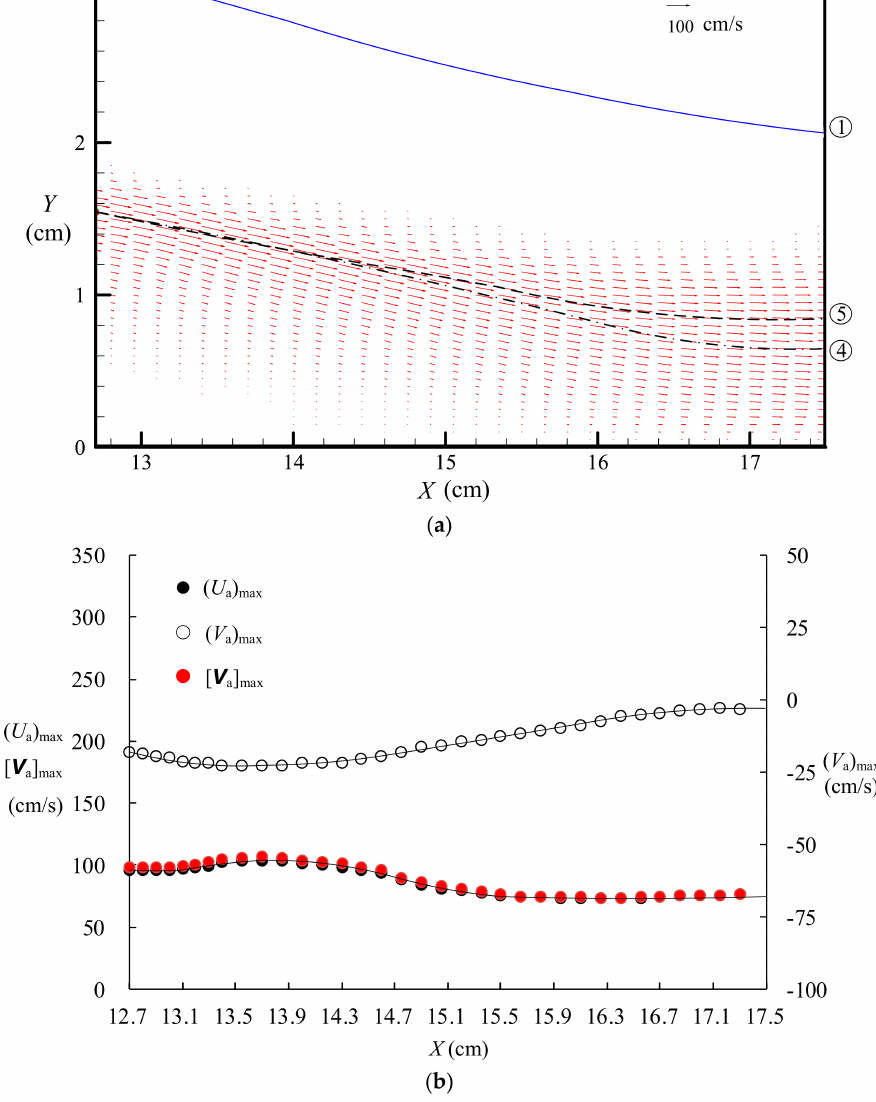
Figure 19. ( a ) Mean velocity field of air bubbles for 12.7 cm ≤ X ≤ 17.5 cm, in which the first water–air interface (marked by 1 (cid:13) ), the virtual boundary ( 4 (cid:13) ), and the dashed curve representing positions for the maximum mean streamwise velocity ( 5 (cid:13) ) are highlighted; ( b ) Variations of the maximum mean streamwise, transverse, and resultant velocities of air bubbles, i.e., ( U a ) max , ( V a ) max , and [ V a ]